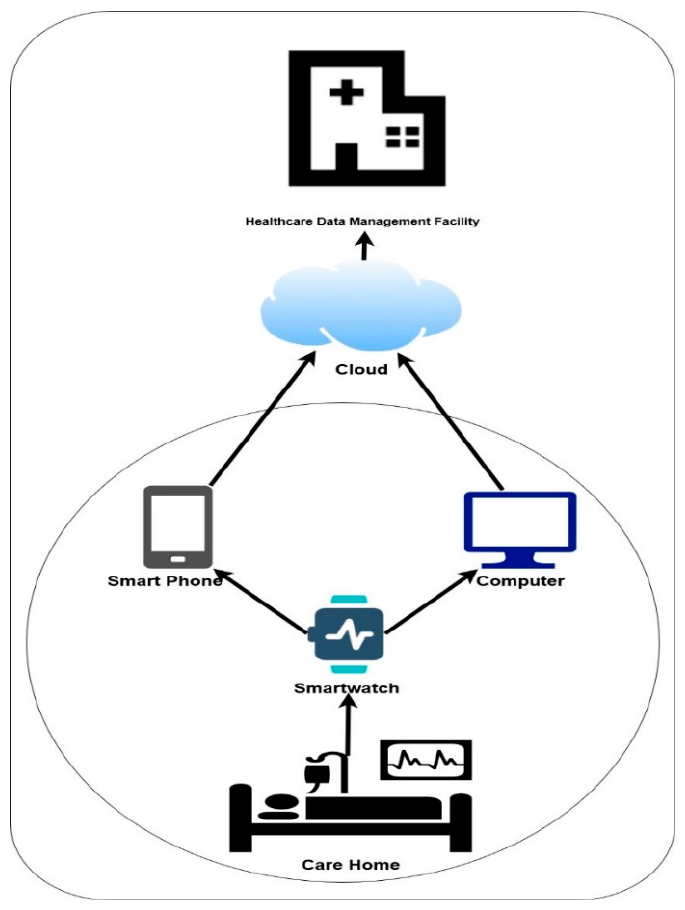
Figure 16. Use case schematic architecture.